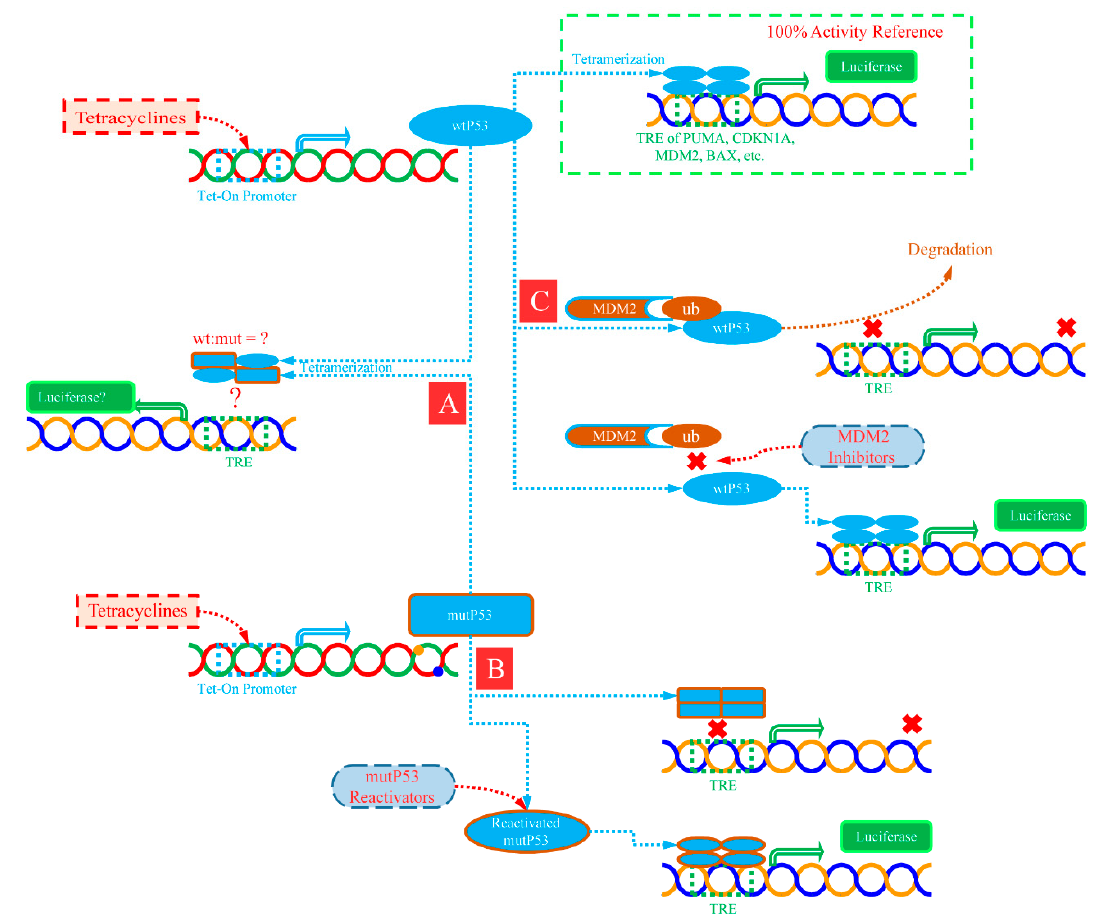
Figure 8. Schematic overview of the improved reporter gene assay and its application. The strategy of tetracycline ‐ inducible expression made P53 expressed controllable only during the experiment. Thus, it provides a 100% active reference with the whole activation state of wild ‐ type P53 for the reporter gene system. The method of calculating the percentage relative to the 100% reference can more objectively reflect the actual biological activity. Based on this solution, incomplete same re ‐ sponse modes of typical transcriptional response elements to the dominant negative P53 mutation effect can be observed ( A ). The system can also be applied to evaluate the ability of compounds to restore P53 activity, including but not limited to mutant P53 reactivators ( B ) and MDM2 inhibitors ( C ).